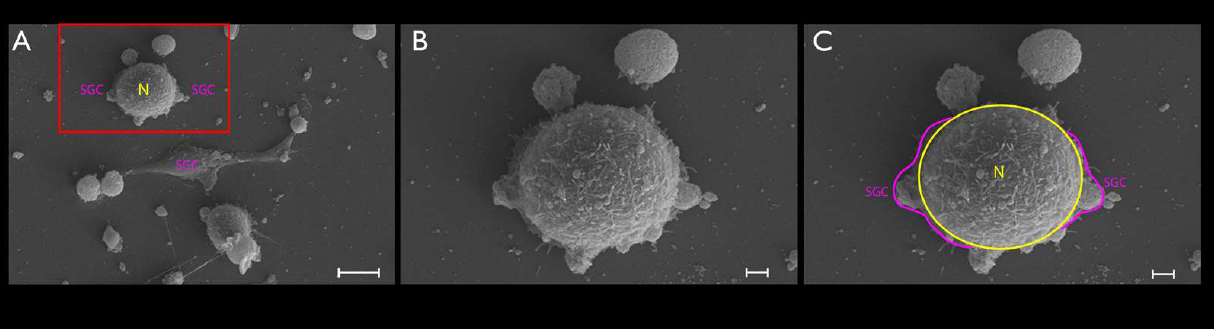
Figure 2. Phase-contrast microscopy of primary cultures of TG after 4 h ( A ), 24 h ( B ), and 48 h ( C ). Within the first four hours, a close relationship between the SGCs and the cell bodies of neurons was detected. This relationship was highlighted in the white square on the left side of Figure 1A (a 3.0 zoom was adopted for better visualization). After 24 h, the majority of the cultured TG SGCs adopted a fusiform shape. ( B ): arrows indicate neurons, arrowheads indicate SGCs. After 48 h, they migrated away from the neurons to which they were originally related and arranged themselves in parallel bundles. Scale bars represent 50 µm.